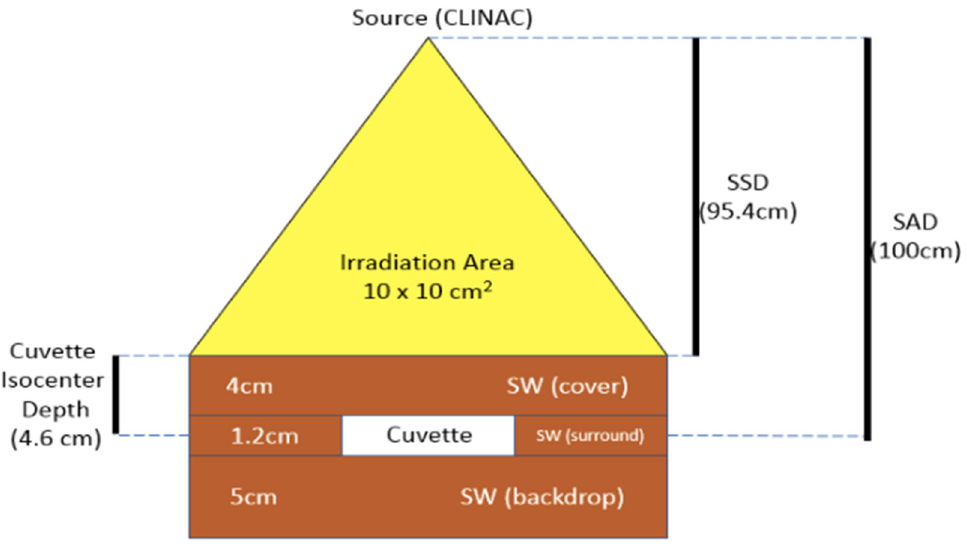
Figure 2. Cuvette irradiation setup. The cuvette was placed on top of a 5 cm thick backdrop of solid water and then surrounded by a solid water layer 1.2 cm thick. An additional 4.0 cm thick layer of solid water was then used to cover the cuvette. The center of the cuvette was moved to the isocenter at SAD = 100 cm. The SSD (source-surface distance) is set to 95.4 cm. The collimator field size is 10.0 × 10.0 cm 2 .